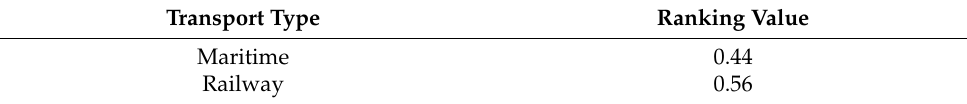
Table 4. Ranking